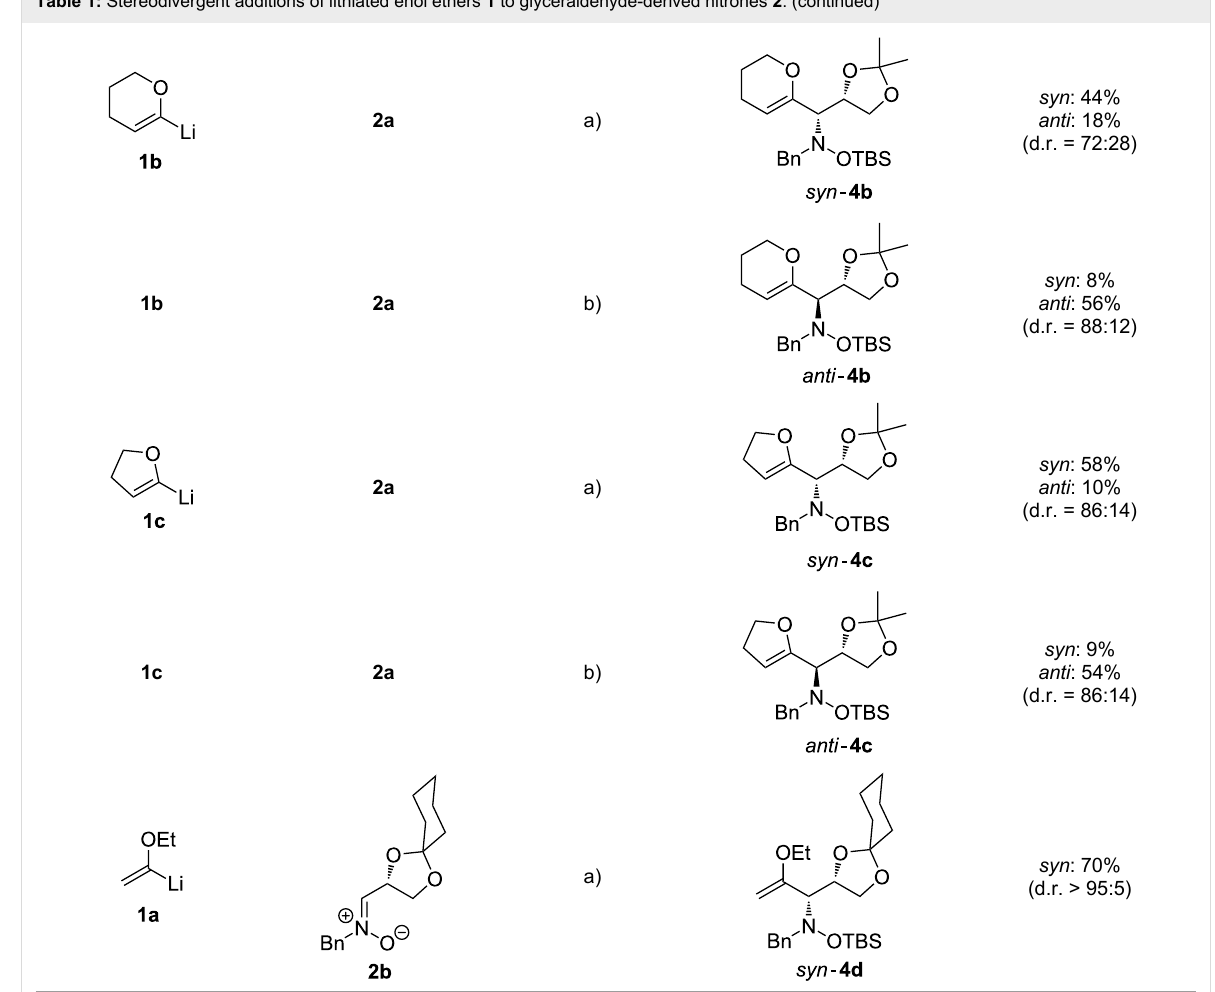
Table 1: Stereodivergent additions of lithiated enol ethers 1 to glyceraldehyde-derived nitrones 2 .